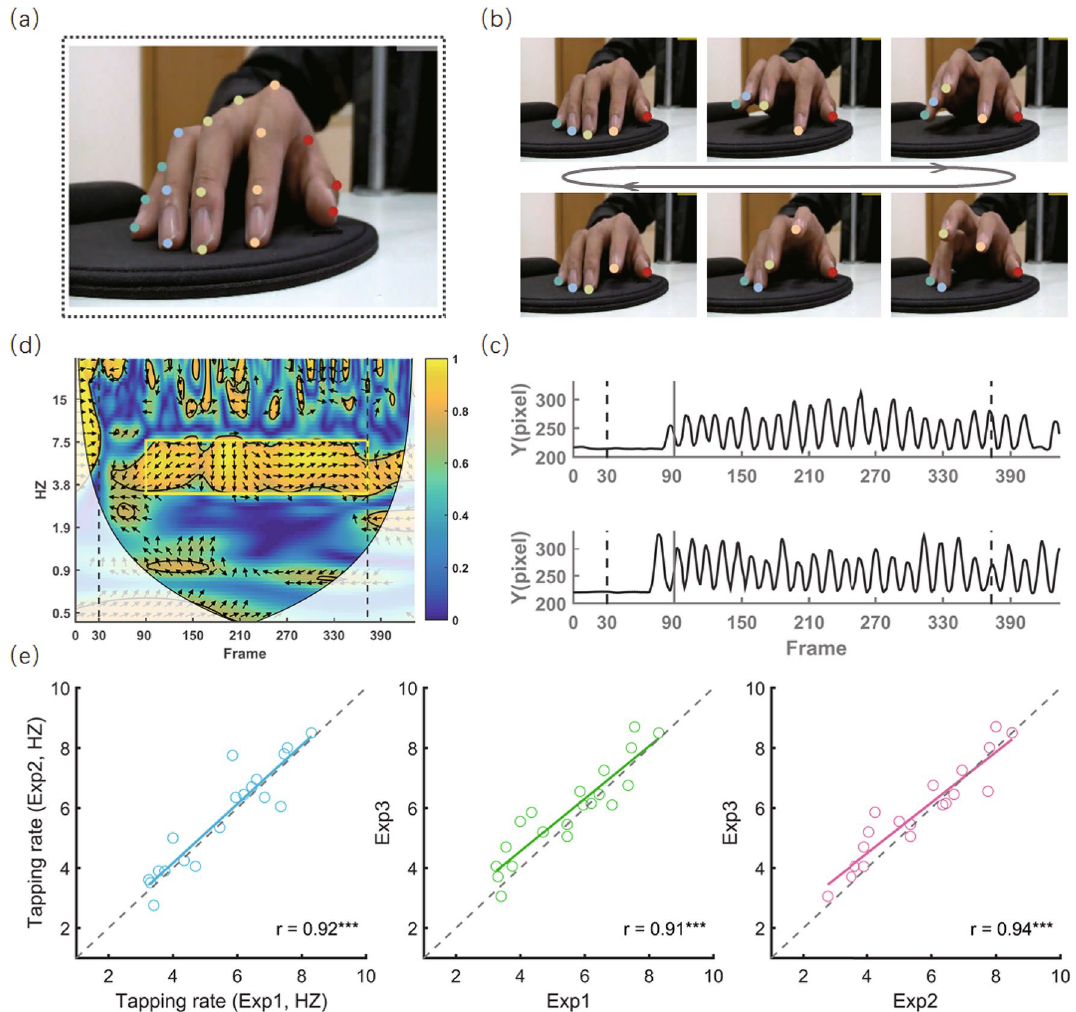
Figure 2. Recording and quantification of automatic finger tapping movements. ( a ) One exemplar frame illustrating the location of 17 key points of interest of the right-hand fingers. For each frame, the coordinates of these points were automatically recognized using DeepLabCut 19 . ( b ) Concrete frames illustrating changes in the position of key points during repetitive finger tapping movements. For visibility, only key points on the fingertips are shown. ( c ) Y-axis trajectories of the index finger from two exemplar trials. Dotted lines represent the onset of pure tones informing participants to initiate and terminate finger tapping, respectively. The solid line indicates the beginning of the temporal range of interest. ( d ) The 2-D map produced by wavelet transform coherence (WTC) analysis between the above two trials. The color bar indicates the coherence intensity, and the orientations of arrows indicate the circular phase lag at each time–frequency point. The yellow rectangle indicates the temporal-frequency range of interest determined for this representative participant. To exclude the distorting effect of edge artifacts, values in the area masked by translucent white were not included in further analyses. ( e ) Tapping rate is individually different but stable across experiments. Though experiments were performed under different task demands and in separate days, the rate of tapping movements between experiments was highly correlated (Pearson r >